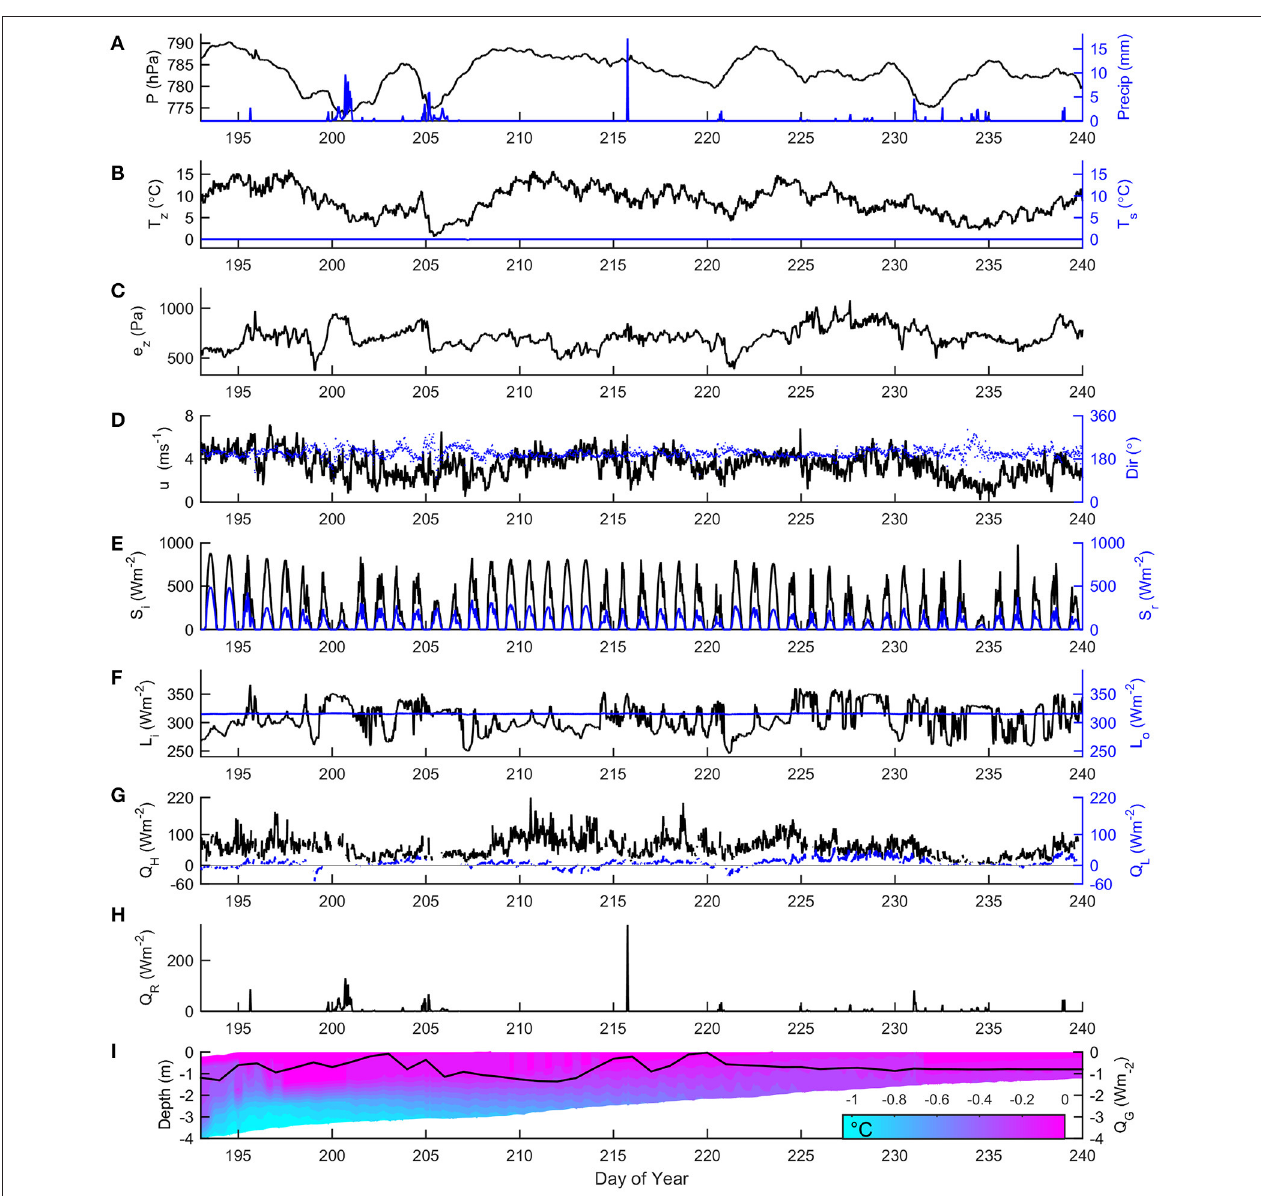
FIGURE 3 | Thirty minute meteorological data and surface energy fluxes for July 12th–August 28th (DOY 193–240) 2014 on Nordic Glacier; (A) pressure and precipitation, (B) 2 m air and surface temperature, (C) 2 m vapor pressure, (D) wind speed and direction, (E) incoming and reflected shortwave, (F) incoming and outgoing longwave, (G) sensible and latent heat fluxes, (H) rain heat flux, and (I) ice temperature profile and ground heat flux.